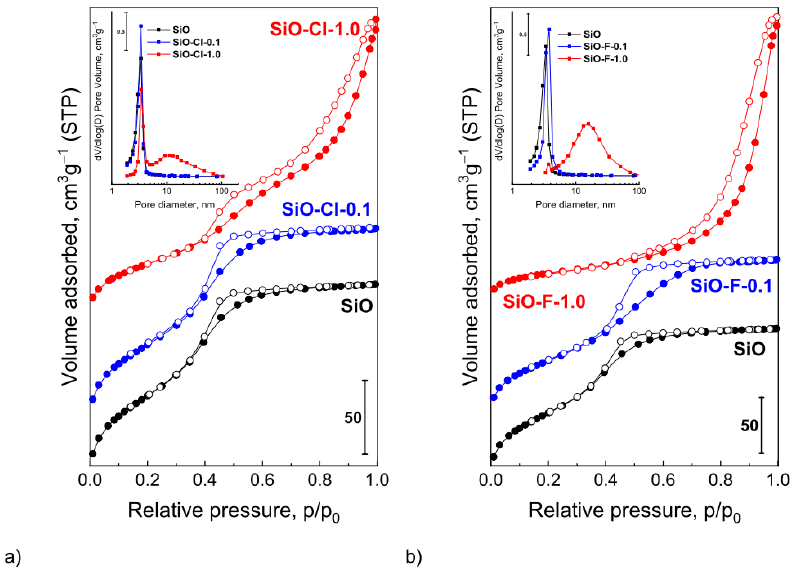
Figure 1. Low-temperature N 2 adsorption/desorption isotherms and pore size distribution